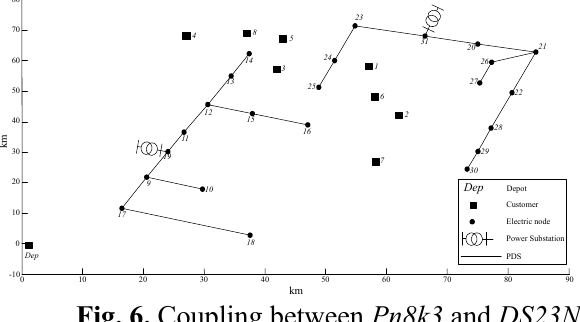
Fig. 6. Coupling between Pn8k3 and